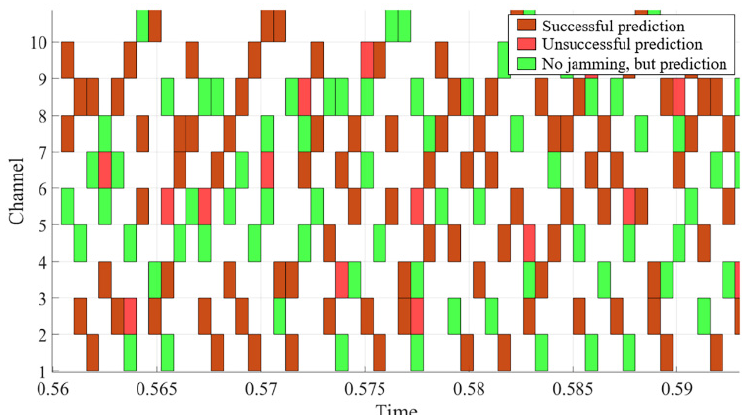
Figure 10. WBSS algorithm anti-intelligent blocking jamming channel decision diagram.